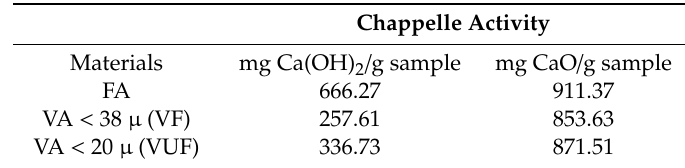
Table 3. Chappelle test results of FA, VF and VUF according to NF P 18-531.